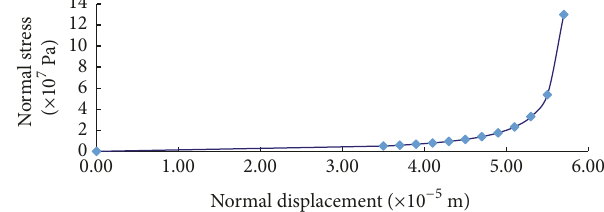
Figure 10: Relationship between normal displacement and normal stress.